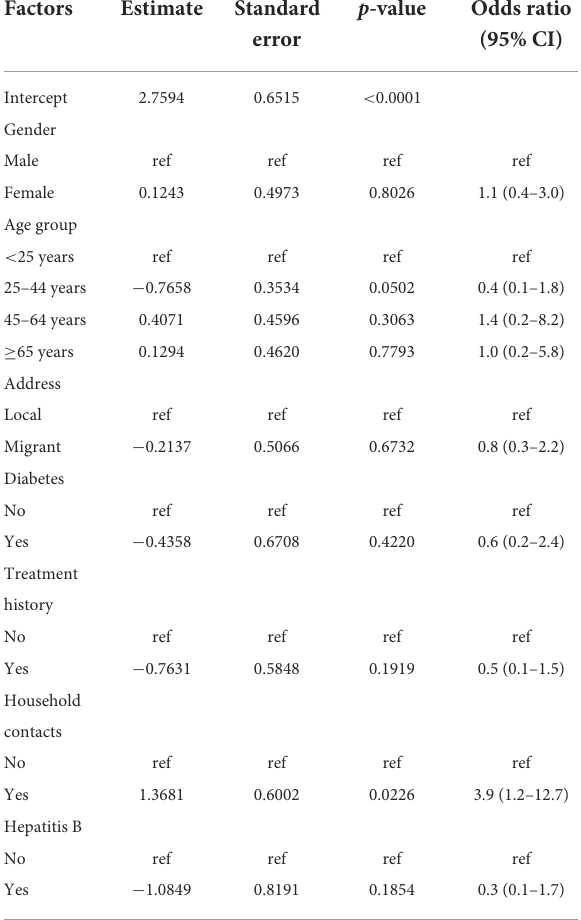
TABLE 3 Characteristics of rifampin-resistant TB by multivariate analysis in Zhejiang Province,